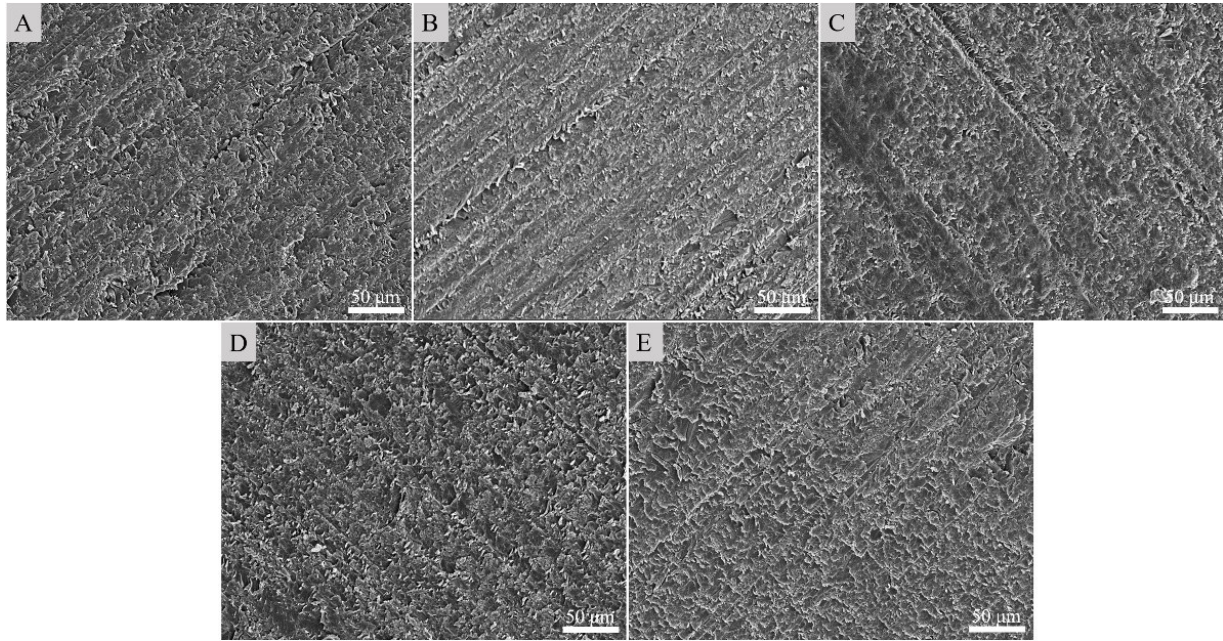
Figure 5. SEM images of neat epoxy ( A ), Ti 3 C 2 /epoxy ( B ), 0.25 M TiO 2 /Ti 3 C 2 /epoxy ( C ), 0.5 M TiO 2 /Ti 3 C 2 /epoxy ( D ), 1.0 M TiO 2 /Ti 3 C 2 /epoxy ( E ) nanocomposites at 0.5% mass fraction after surface polishing treatment with SiC abrasive paper.